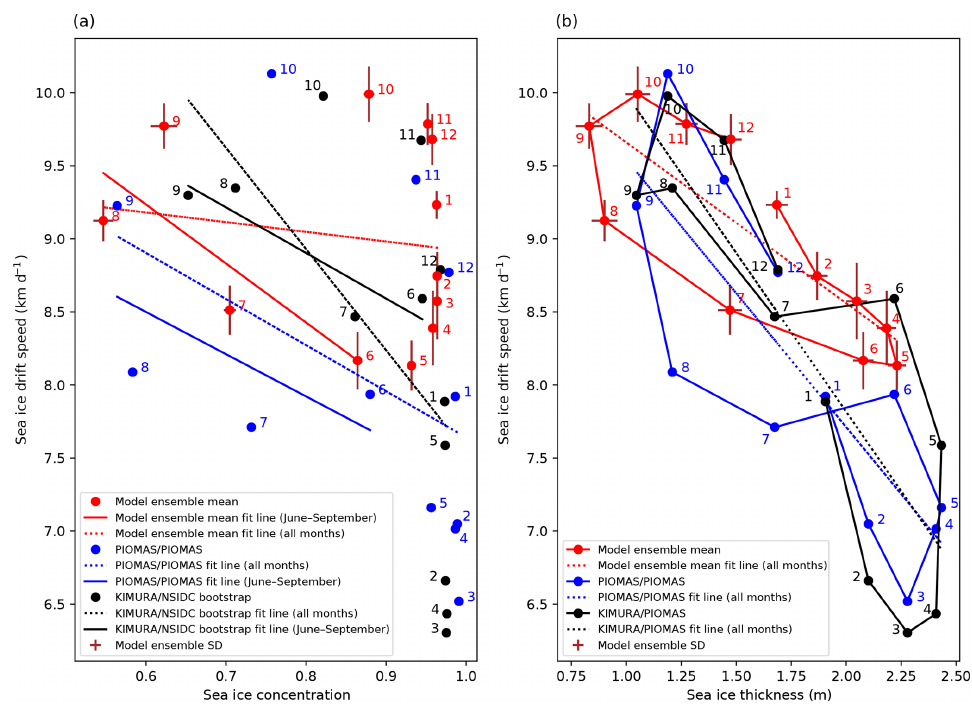
Figure 6. Scatter plots of monthly mean sea ice drift speed against (a) sea ice concentration and (b) sea ice thickness, averaged over the period of 2003–2014 and the study domain (indicated in Fig. 1). Numbers denote the months. Results are shown for the model (HIRHAM– NAOSIM 2.0) ensemble simulations (red), KIMURA for ice drift speed plus NSIDC bootstrap for ice concentration (black), and for PIOMAS data